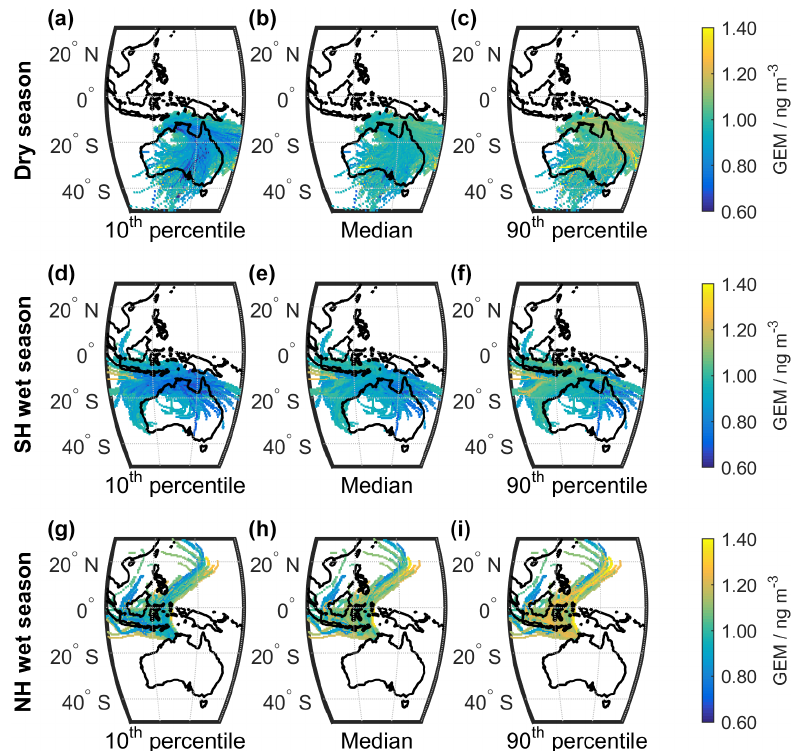
Figure 6. 10th percentile (left), median (centre), and 90th percentile (right) of hourly GEM-weighted HYSPLIT trajectories for 0.5 ◦ × 0.5 ◦ grid squares. Panels (a) – (c) are for dry-season data, (d) – (f) for SH wet-season data, and (g) – (i) for NH wet-season data. NH wet-season map created using 10-day back trajectories, all others using 5-day